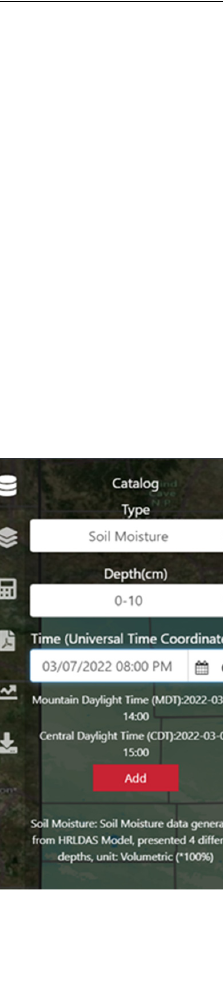
Figure 3. The Nebraska maps of its: ( a ) location; ( b ) crop types; ( c ) soil texture class; and ( d ) annual total precipitation (mm).